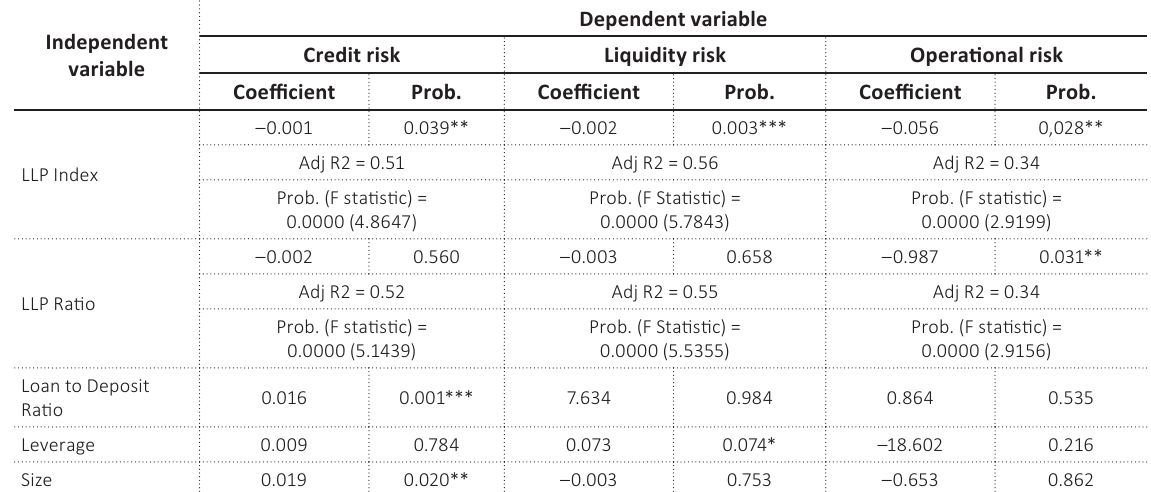
Table 2. Hypothesis